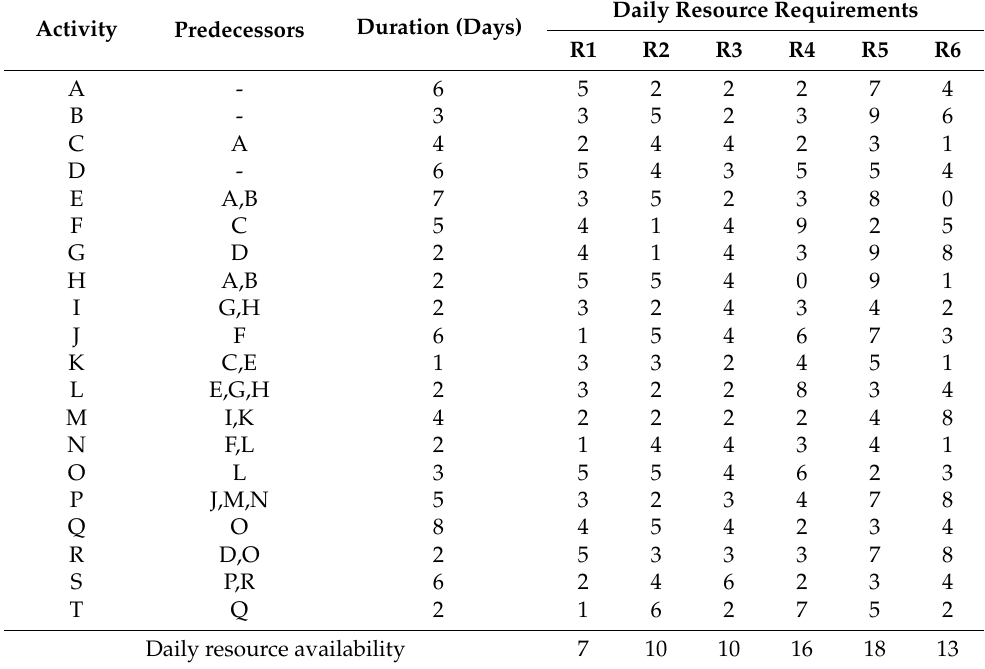
Table 6. Project information for Project B.